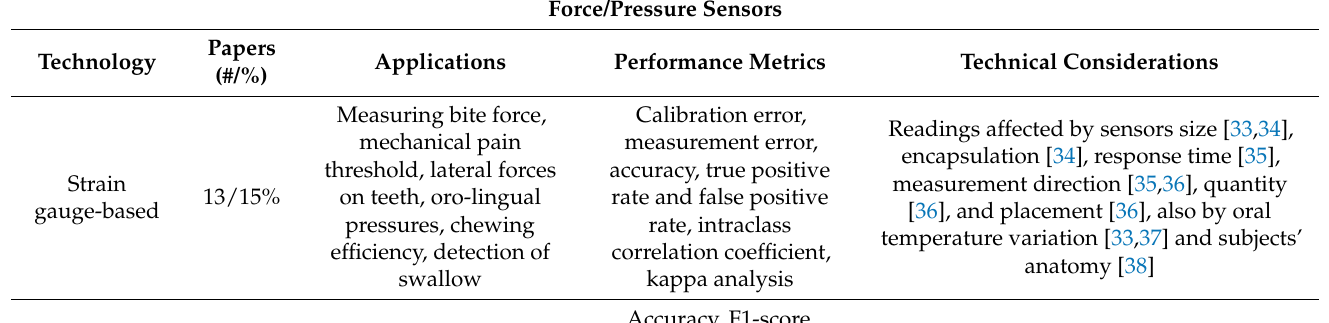
Table 2. A list of field of application for each sensor technology, as well as their performance metric and any technical consideration reported on within the papers. It should be noted that a single paper or study might explore multiple sensor